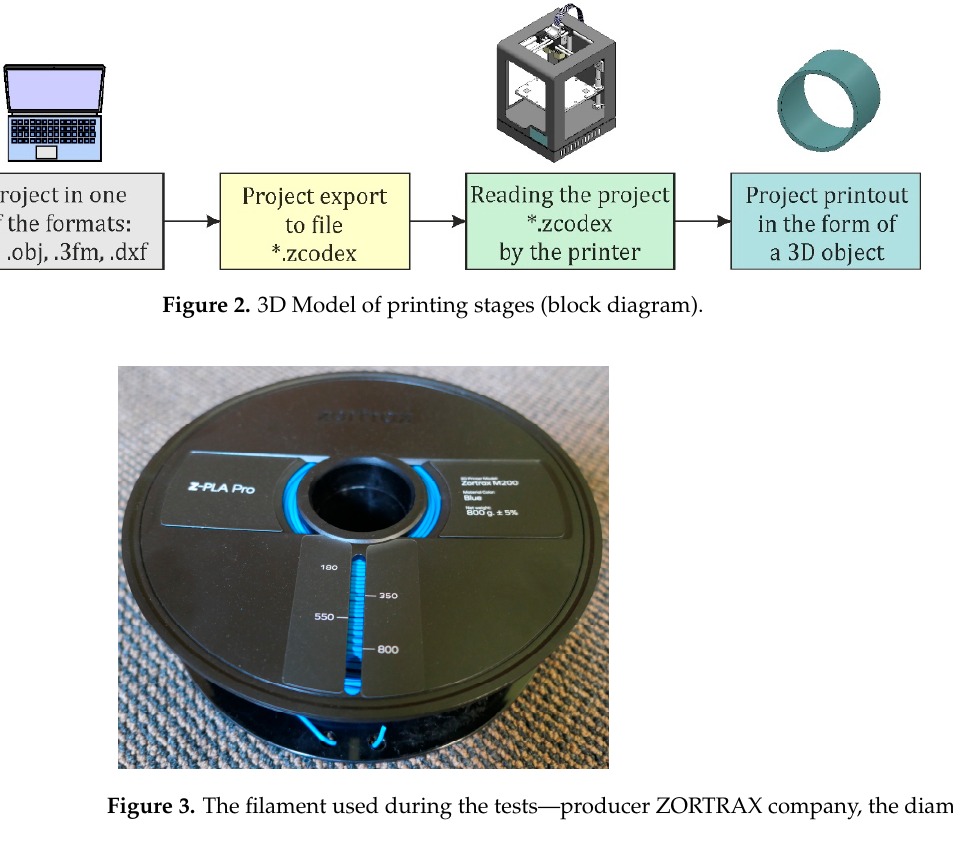
Figure 4. The checked locations of the accelerometer on the printer housing.